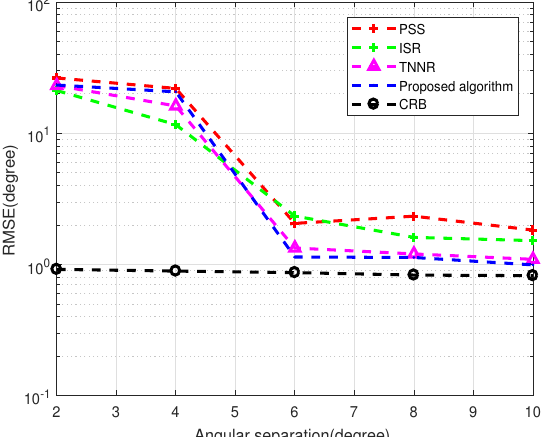
Figure 8. RMSE versus the angular separation for two uncorrelated